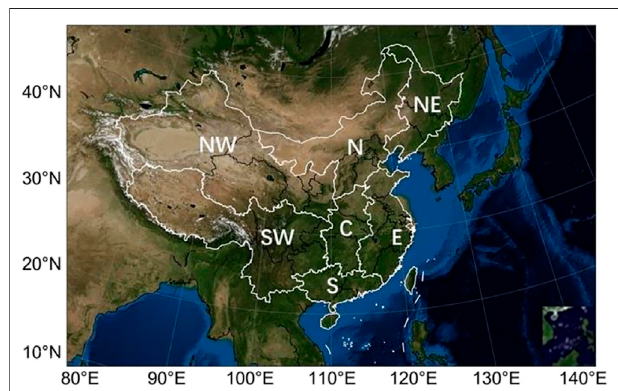
FIGURE 1 | Model domain and sub-regions used for analysis. E: East China, N: North China, C: Central China, S: South China, SW: Southwest China, NW: Northwest China, NE: Northeast China.